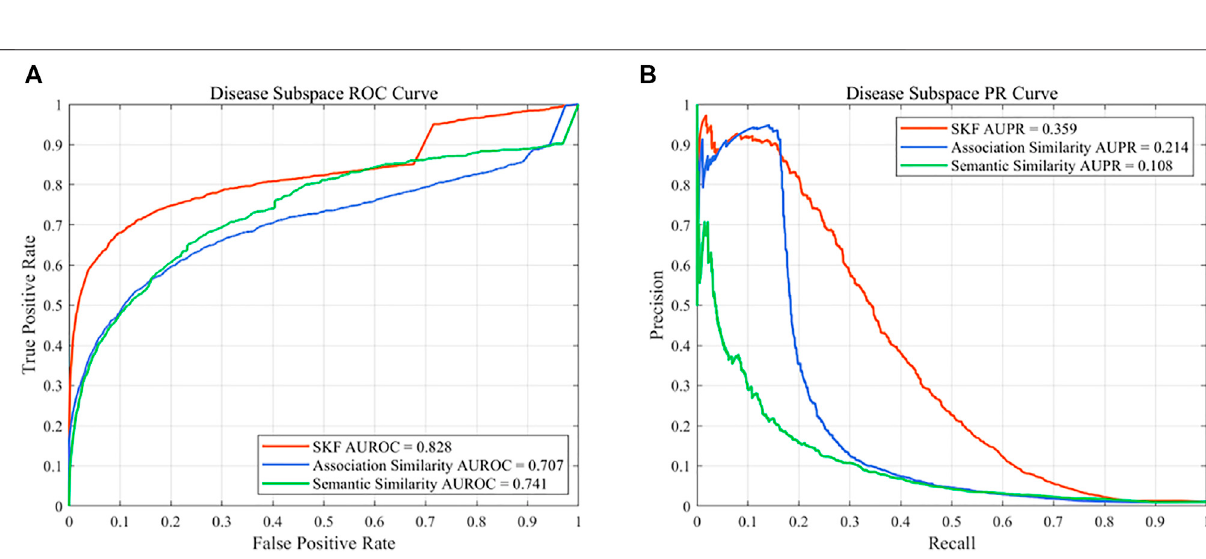
Frontiers in Pharmacology |